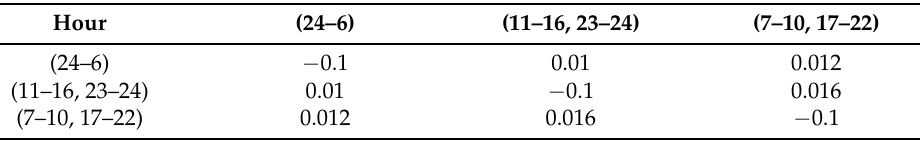
Table 4. Self and cross elasticities [29].